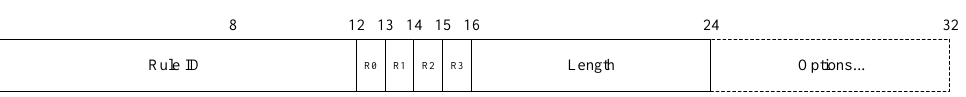
Figure 8. SCHC context advertisement object.